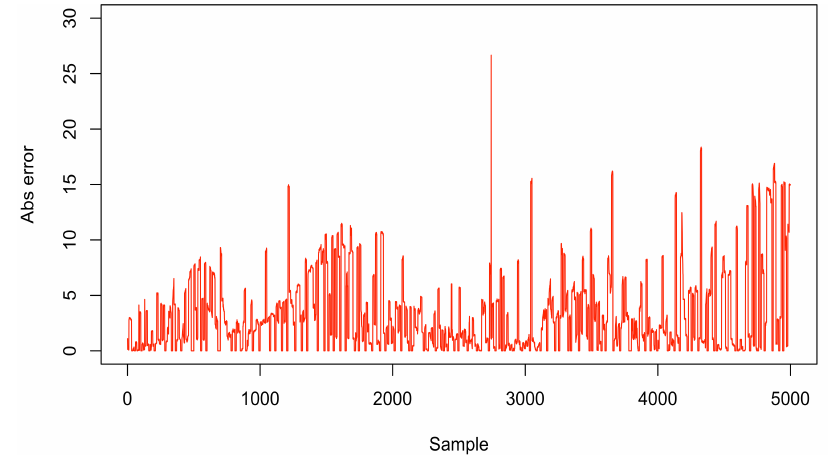
Figure 16. Absolute error in LEACH scenario with P equals to